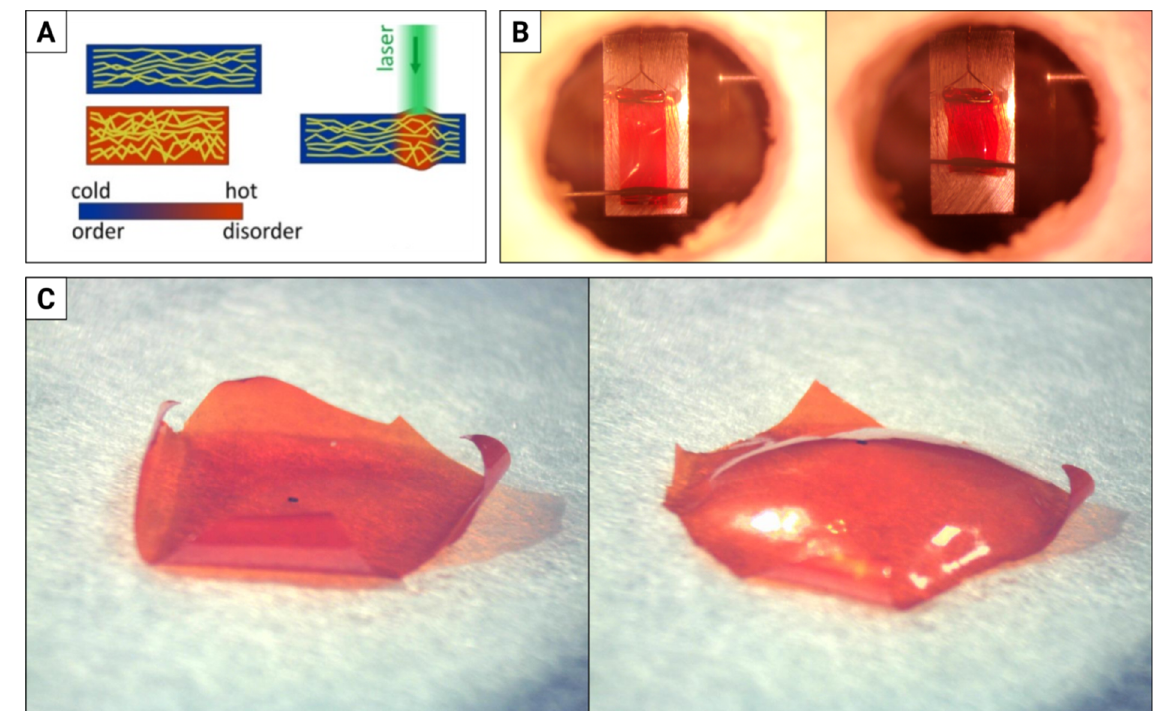
Figure 1. Light-responsive LCE—from a simple contracting strip to films with arbitrary molecular alignment. ( A ) A piece of material with cross-linked polymer chains (olive) arranged in one direction undergoes a phase change in response to temperature increase, either in the entire volume (left) or locally, when illuminated with a green laser beam (right): the molecular order decreases, the polymer chains effectively shorten along the director and macroscopic deformation results. ( B ) A 10 mm long strip of LCE film heated in an oven from 29 °C to 150 °C shortens by approximately 35%. ( C ) A 22 × 22 mm piece of flat LCE film with azimuthal director orientation (the black dot marks the center of rotational symmetry) buckles when heated on a hot plate from 22 °C to 80 °C.